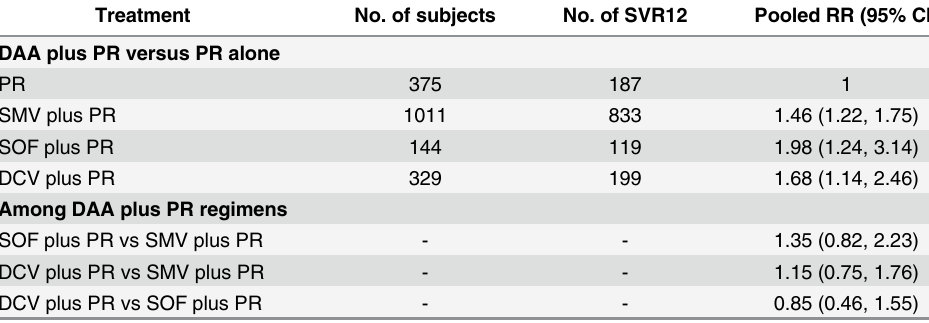
Table 4. Network meta-analysis of sustained virological response at week 24 after the end of treatment. Treatment No. of subjects No. of SVR12 Pooled RR (95% CI) DAA plus PR versus PR alone PR 375 187 SMV plus PR SOF plus PR DCV plus PR 329 Among DAA plus PR regimens SOF plus PR vs SMV plus PR - - DCV plus PR vs SMV plus PR - - DCV plus PR vs SOF plus PR - - 0.85 (0.46,